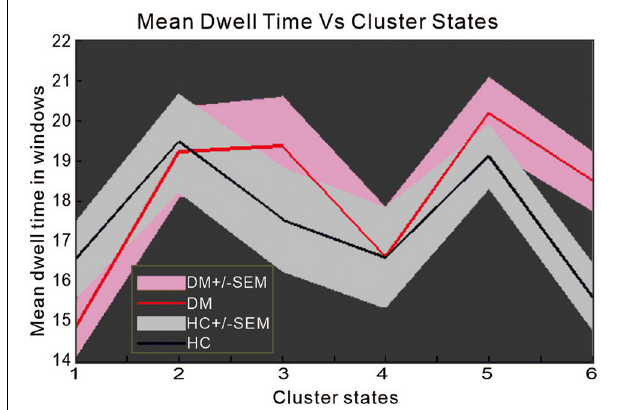
FIGURE 5 | The difference in mean dwell time between patients with type 2 diabetes mellitus and normal controls.